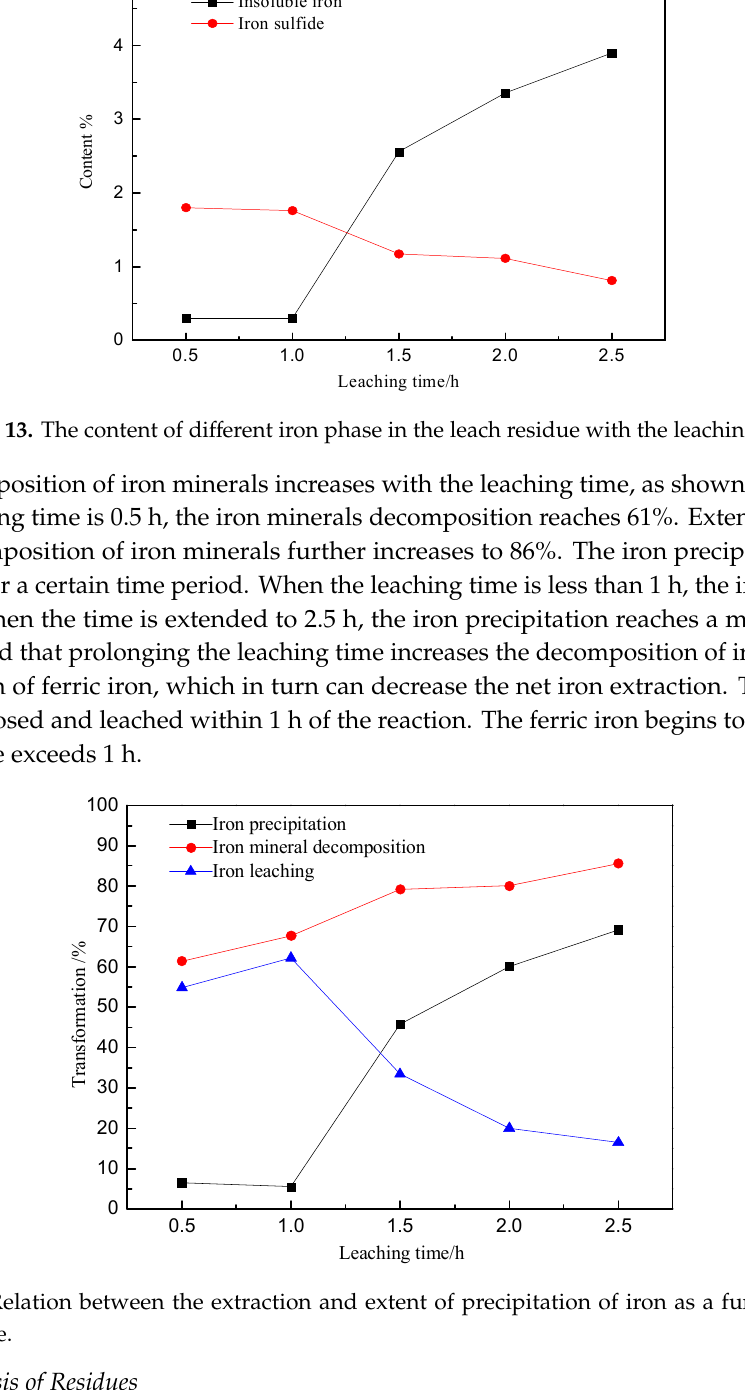
Figure 12. XRD patterns of leach residues with different leaching times.